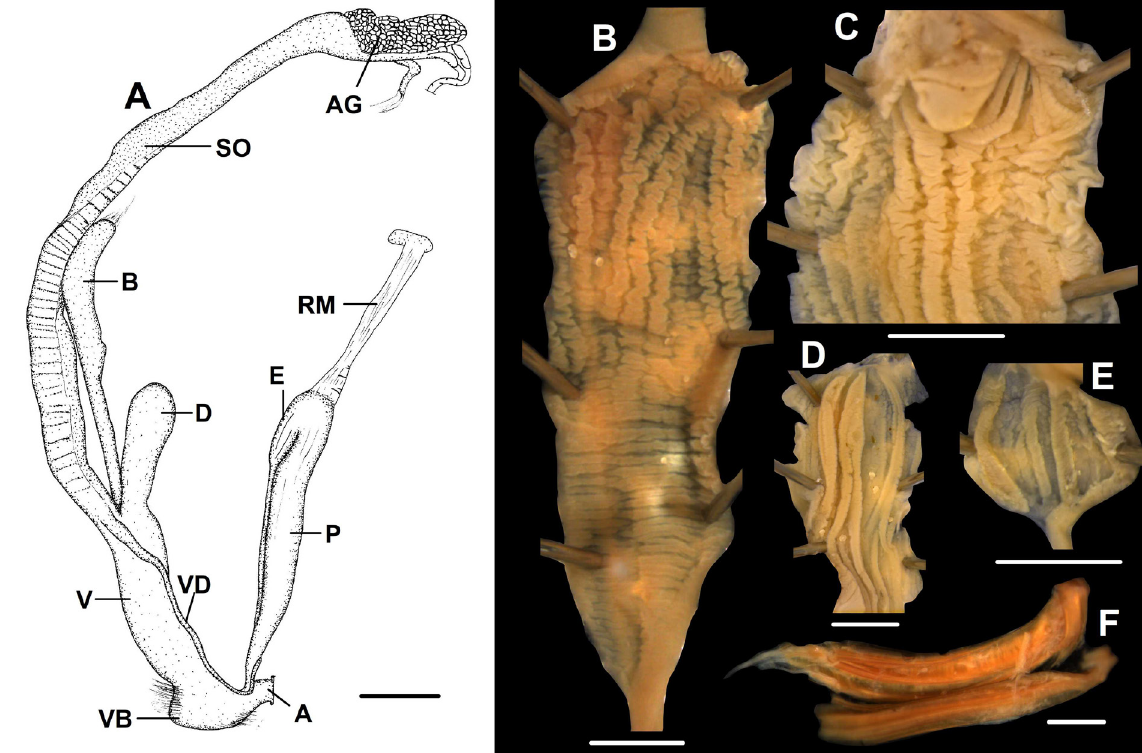
Fig. 42. Genitalia of Plectopylis crassilabris sp. nov. A . Whole genitalia (UF 376790). B–E . Inner structure of genital organs (B = penis, C = vagina, D = diverticulum, E = epiphallus) (UF 376790). F . Spermatophore, PL088 (UF 343899). Scale bars: A = 5 mm; B–F = 1 mm. For abbreviations see Fig. 2. All photos: B.